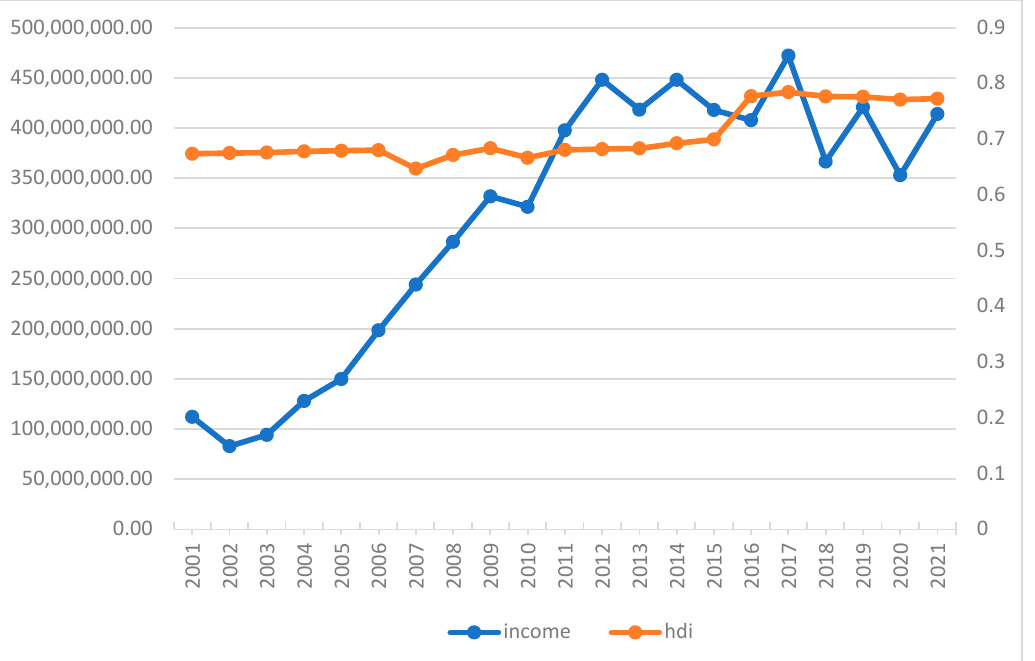
Figure 7. HDI and FRA Güneydo ğ u Anadolu 2001–2021. Source: Turk Statistical Institute.